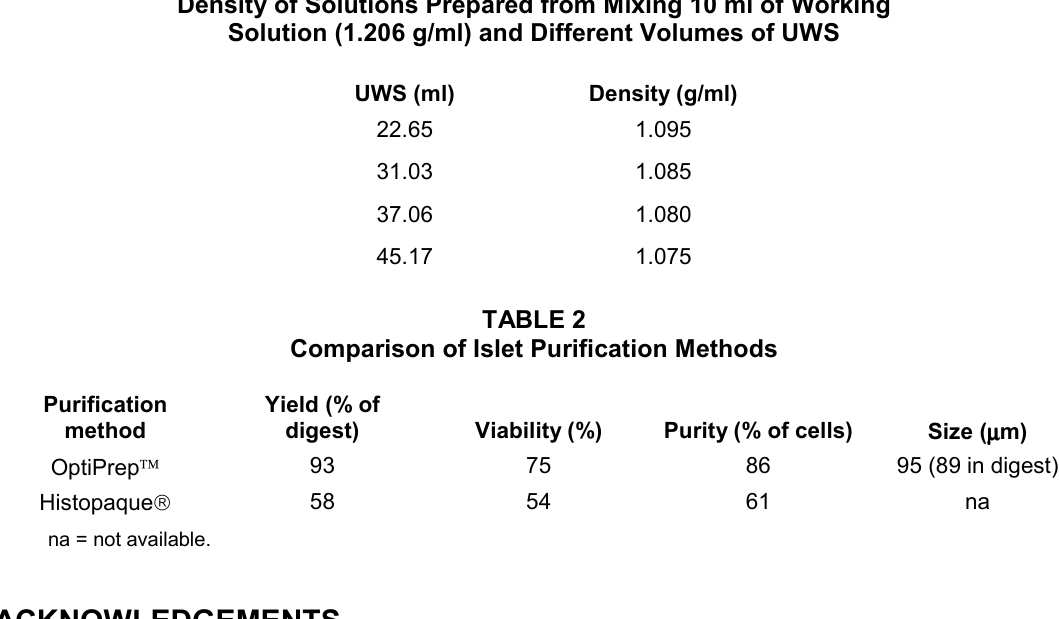
Density of Solutions Prepared from Mixing 10 ml of Working Solution (1.206 g/ml) and Different Volumes of UWS